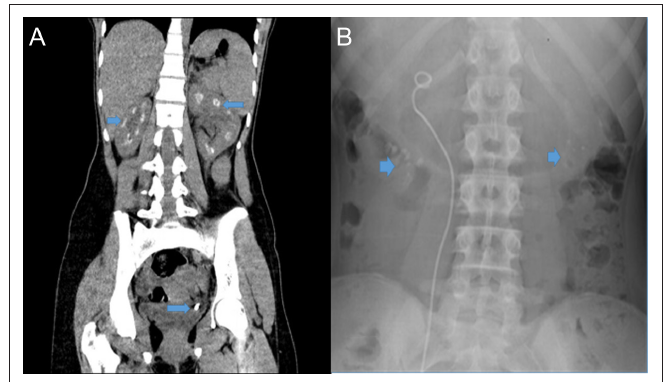
Figure 4. Abdominal radiographs of case 4, showing a diffuse density increase in the pyramidal structures of the bilateral kidneys and an appearance consistent with 2 cm stones in the lower poles (nephrocalcinosis), grade 3 hydronephrosis in the left kidney, and a 7 mm stone in the left ureter distal (A), and an appearance consistent with nephrocalcinosis in areas matching the kidney lodge